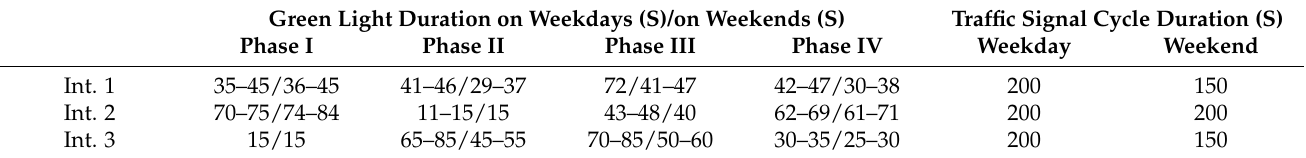
Table 2. Durations of each green light phase and traffic signal cycle.